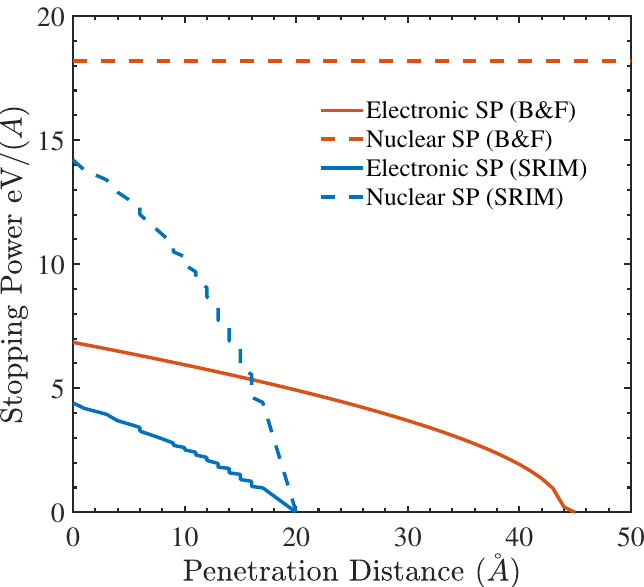
Figure 4. Stopping power of a 6keV carbon ion as a function of penetration distance in a copper target. Calculations by Beuhler and Friedman [38] assumed no scattering. SRIM values are estimated from the SRT